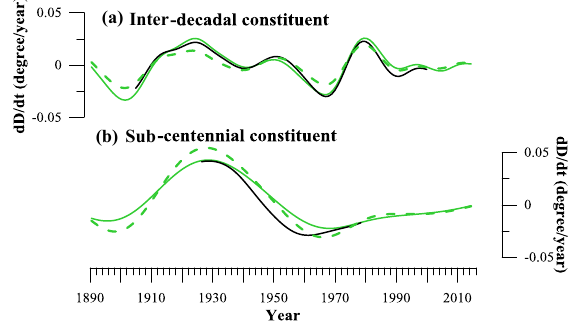
Figure 4. Constituents of the first time-derivative trend of decli- nation at Niemegk Observatory (the red curve in Fig. 3a). (a) The inter-decadal constituent of the trend as a 30-year cutoff high-pass Butterworth filtering (green) and as a residual after the removal of a 30-year running average filtering (black) from the trend, the “ ∼ 22- year” constituent from a 22-year cutoff high-pass Butterworth filter- ing (dashed green). (b) The sub-centennial constituent of the trend as a 73-year cutoff Butterworth filtering (green) and as a residual after the removal of a 73-year running average filtering from the 30-year smoothed trend (black), the “ ∼ 80-year” constituent from a 78-year cutoff Butterworth filtering (dashed